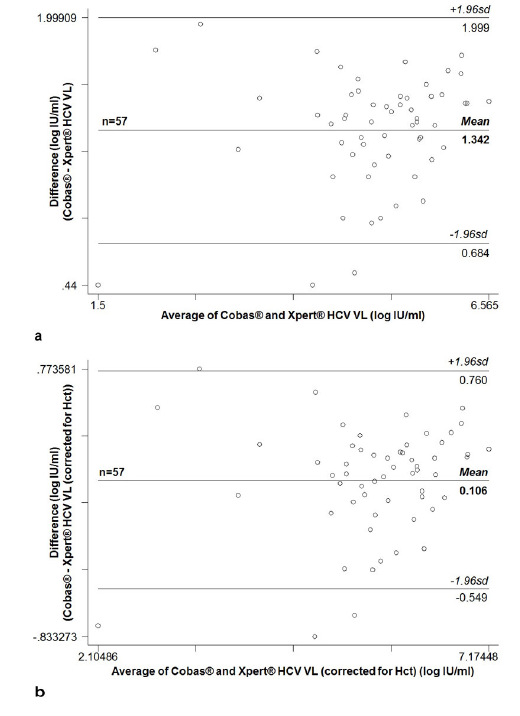
Figure S2: Bland-Altman plot of 57 paired quantifiable HCV RNA measurements for which same-day haematocrit was available: